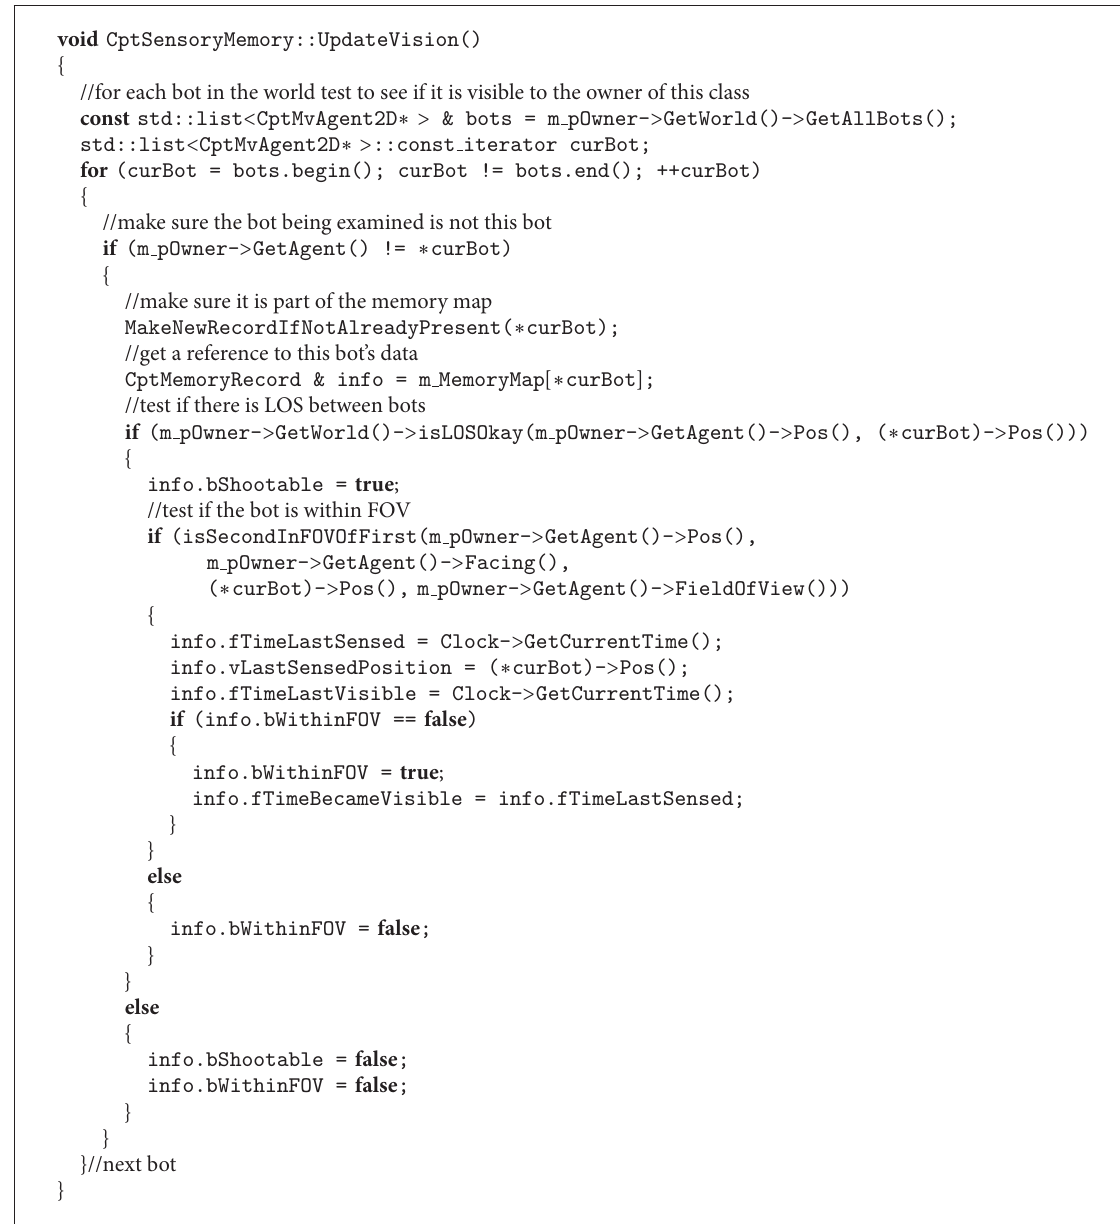
Algorithm 16: Vision update in the Graven sensory memory